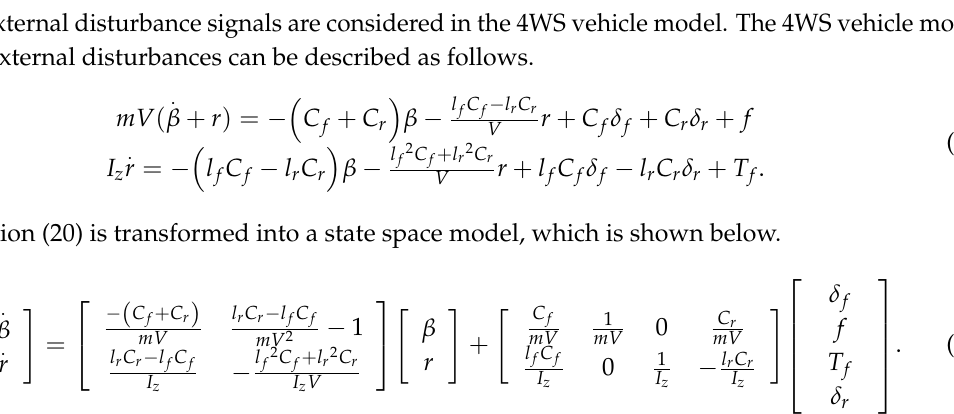
Figure 7. Block diagram of the robust control considering uncertainties.